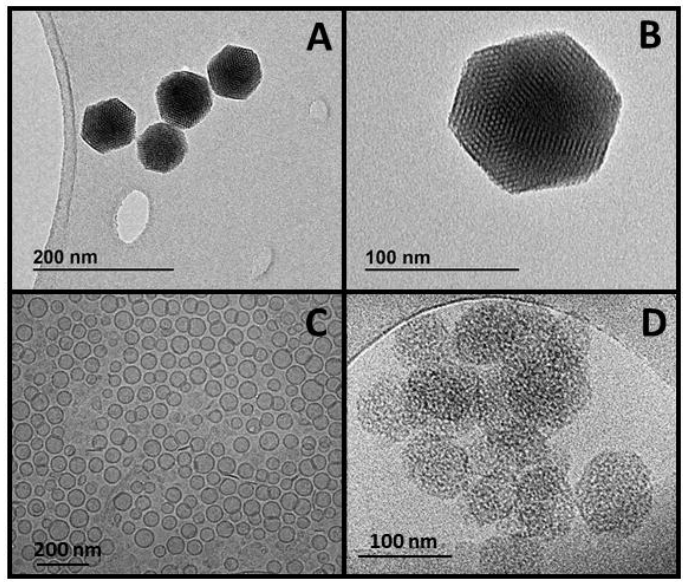
Figure 3. ( A , B ) Transmission electron microscopy (TEM) images of mesoporous silica nanoparticles (MSNPs). ( C ) Cryo-TEM image of Promitil (pegylated liposomes with MLP). ( D ) Cryo-TEM image MLP-loaded MSNP.